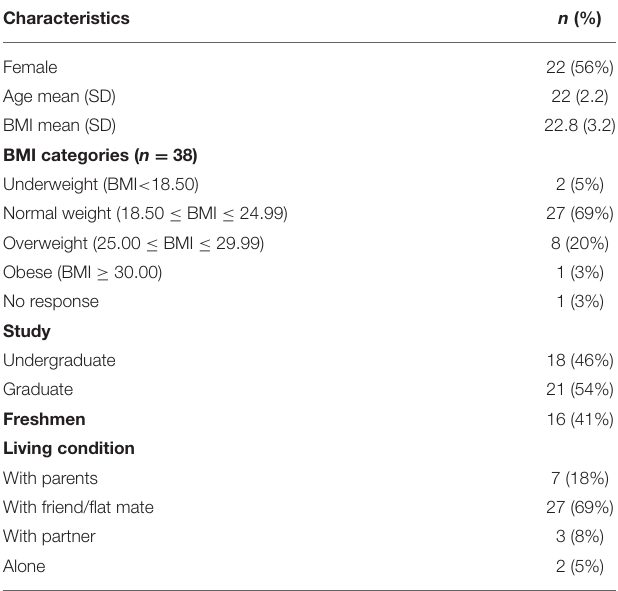
TABLE 1 | Participants’ characteristics ( n =